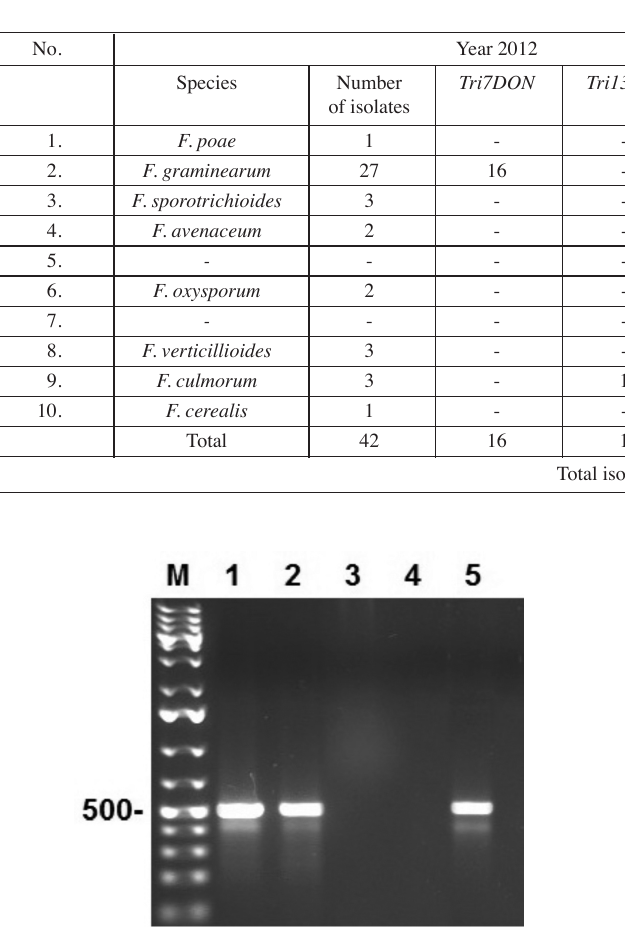
Fig. 1: PCR detection of Fusarium graminearum using species-specific primer set: Fgr-F/Fgr-R; M – DNA size marker GeneRuler DNA Ladder Mix (ThermoScientific, Canada); 1, 2, 5 – positively identified F. graminearum isolates; 3, 4 – negatively identified F. graminearum isolates.